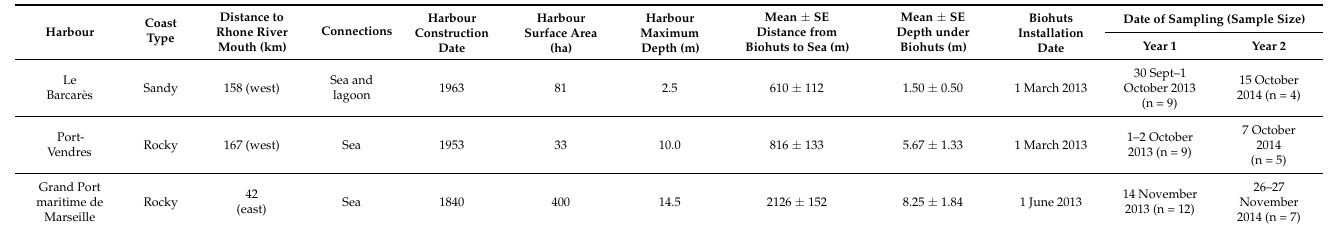
Table 1. Characteristics of the three study sites (harbours) and Dock Biohut